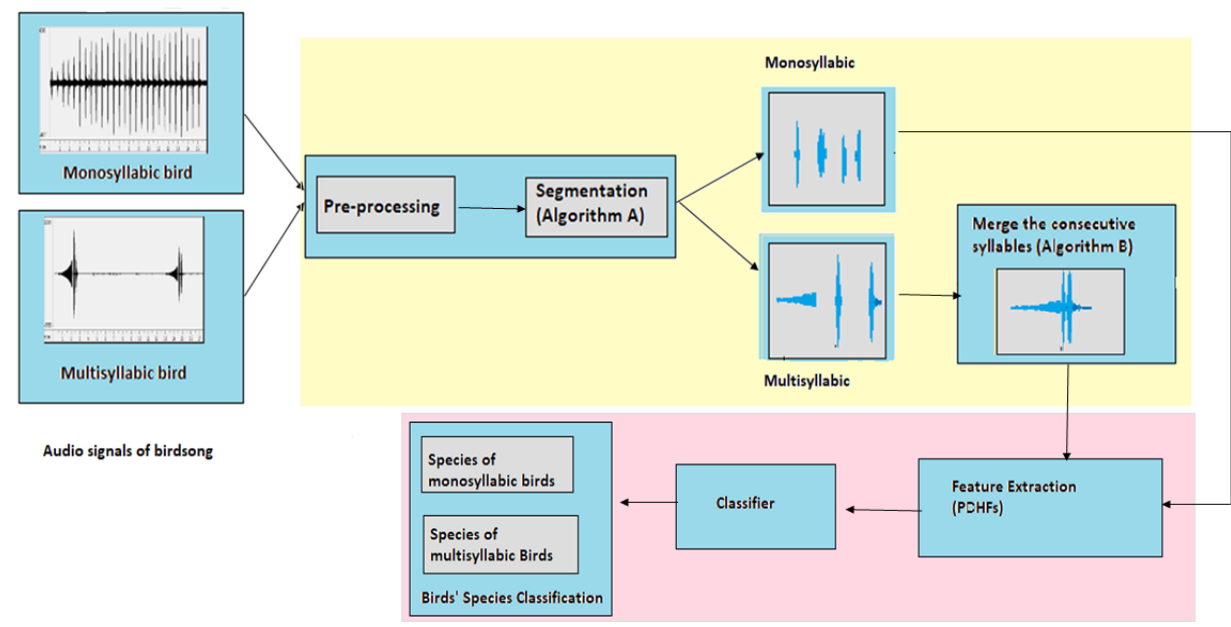
Figure 1. A schematic overview of birdsong segmentation and feature extraction. The input consists of labeled audio (.wav) files of two types of bird: monosyllabic birds and multisyllabic birds. The final output is the birds’ species classification. The two main contributions of this research are shown in two different boxes: the yellow box represents the segmentation and the pink box shows the feature extraction and classification. Before segmentation, preprocessing is applied to remove noise. The filtered audio is then segmented by applying Algorithm A. This algorithm extracts every syllable present in the recording. The single syllables are taken for feature extraction in monosyllabic birds. On the other hand, the consecutive syllables are combined by applying Algorithm B for multisyllabic birds and this segmentation is taken for feature extraction. The feature vector (PDHF) is calculated in the same way for both types of bird and used for bird species